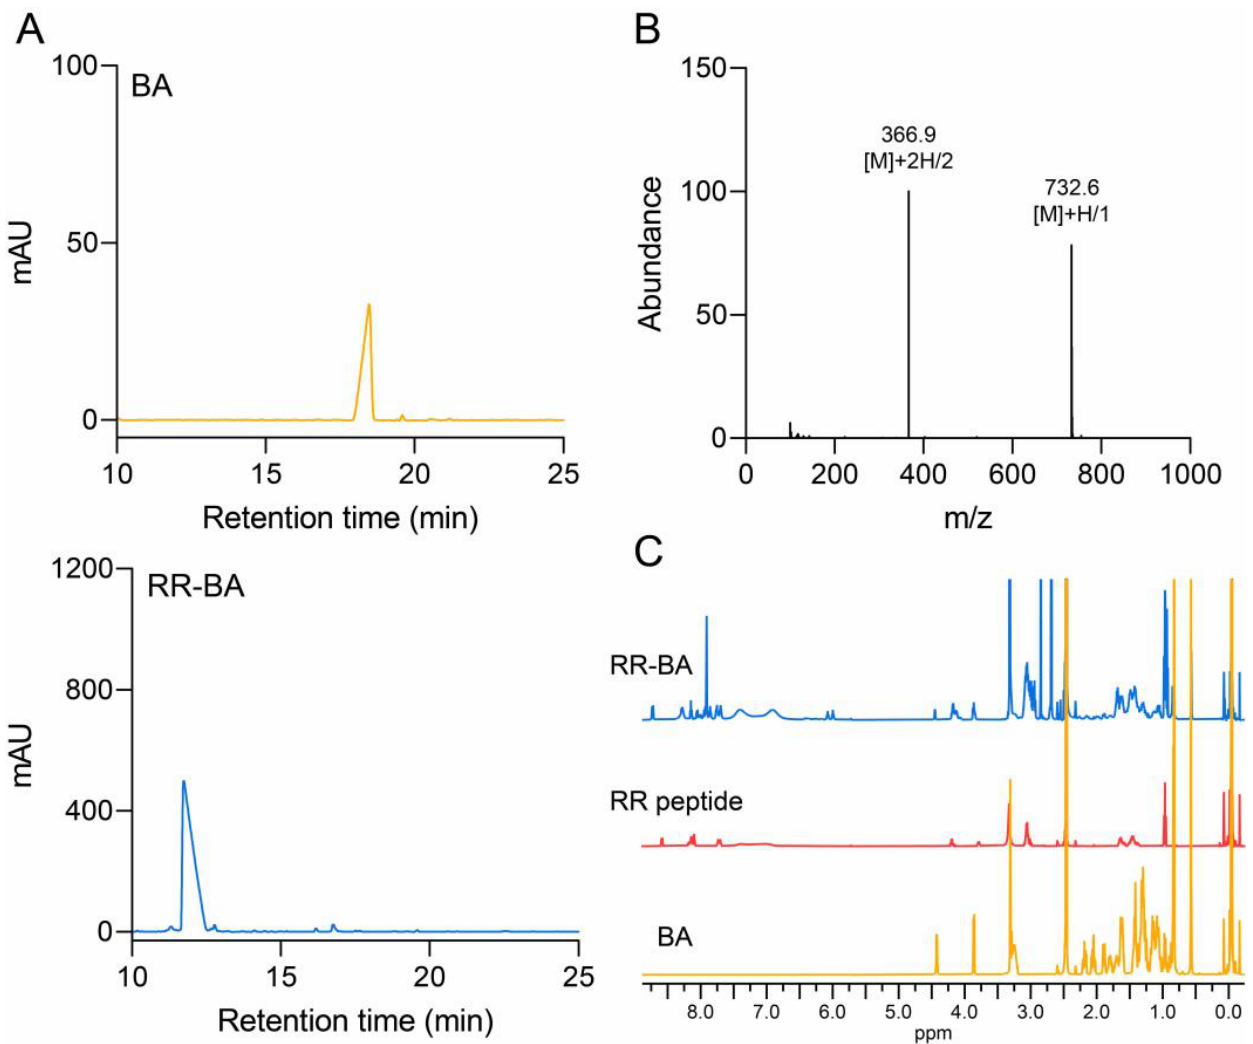
Figure 2. Characterization of RR–BA as a cathepsin B inhibitor. ( A ) The RP-HPLC result showed not only the synthesis of the RR–BA molecule but also that it was endowed with hydrophilicity. ( B ) HPLC-MS chromatogram of RR–BA (MW = 731.5) in positive ionization mode. ( C ) The 1D proton NMR spectrum of RR–BA, RR peptide, and BA in DMSO-d6 was measured using a 500 MHz NMR spectrometer.